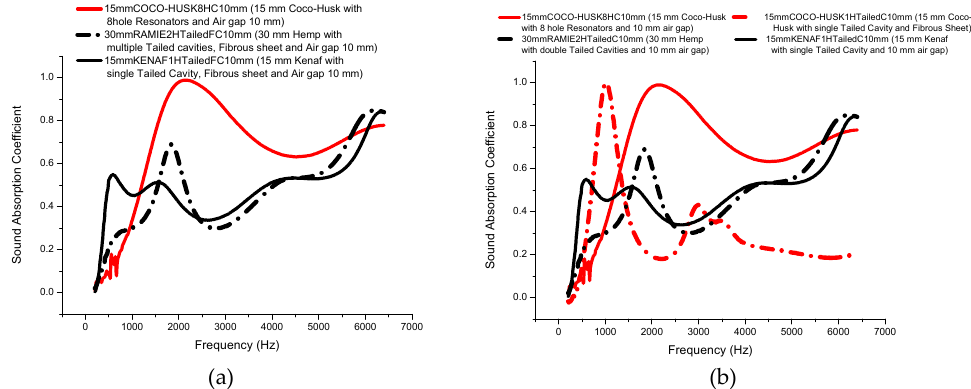
Figure 8. Absorption comparison of coco-husk fibers in previous research and biomass materials with tailed cavity inclusion.